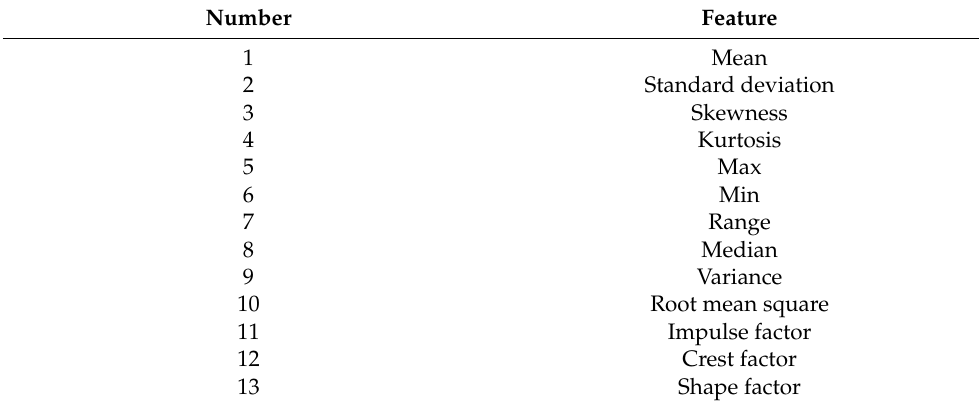
Table 2. Features from time-domain.